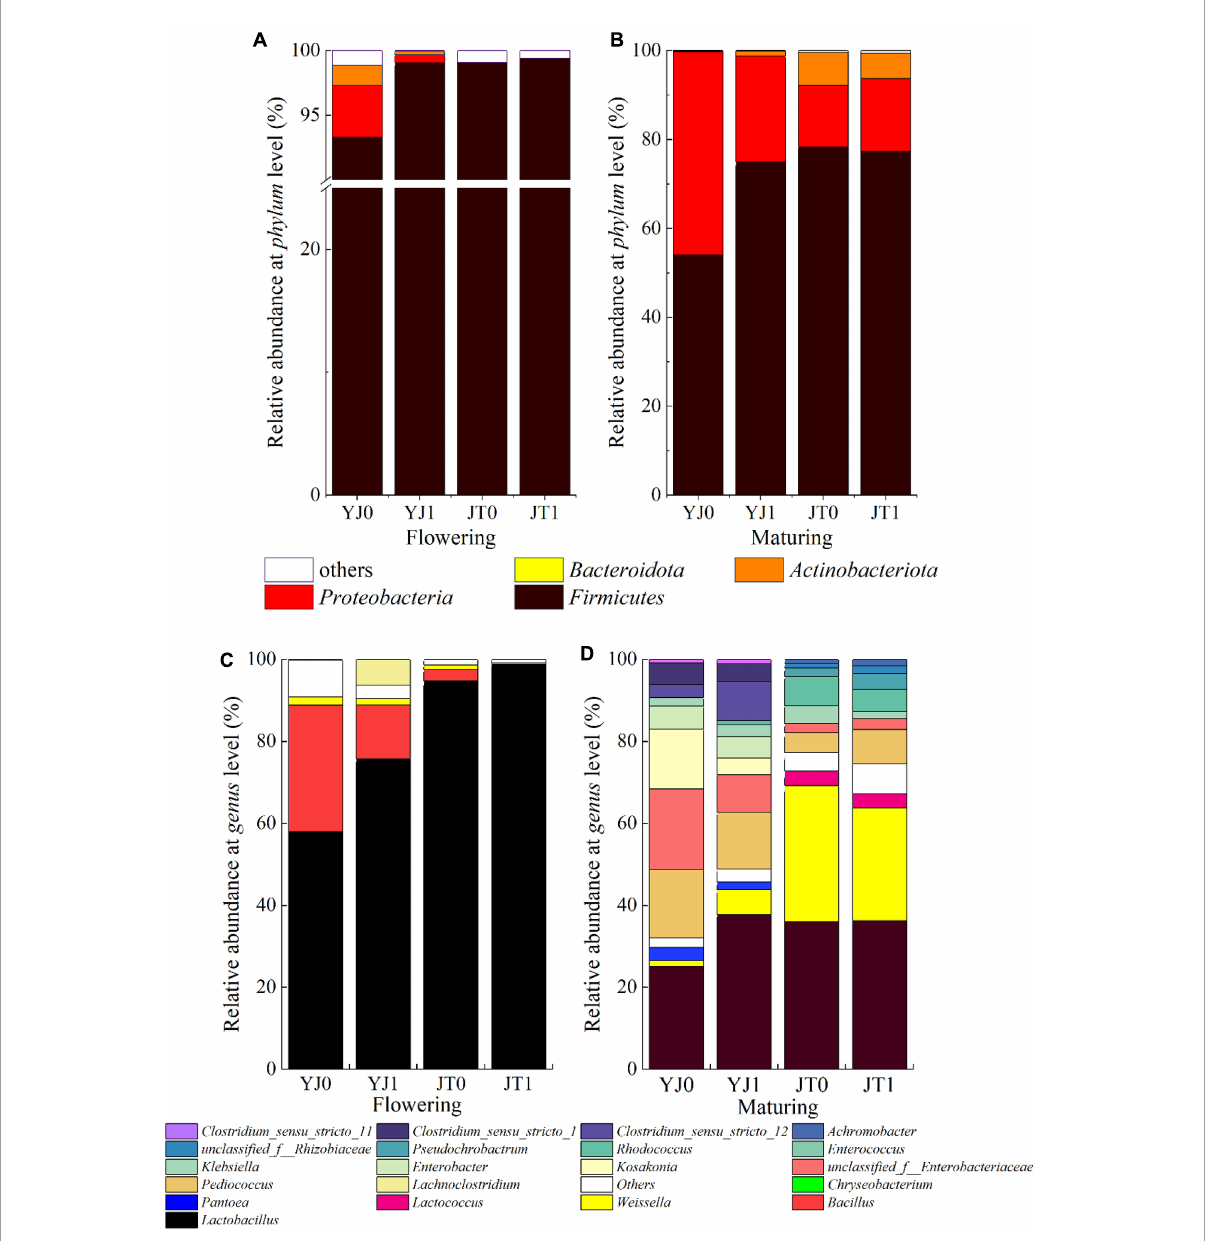
FIGURE2 The effects of sheath bloom on the bacterial abundance at phylum (A,B) and genus (C,D) level in ensiled sweet sorghum at flowing and maturing stages, respectively. YJ0, Yajin without bloom; YJ1, Yajin with bloom; JT0, Jintian without bloom; JT1, Jintian with